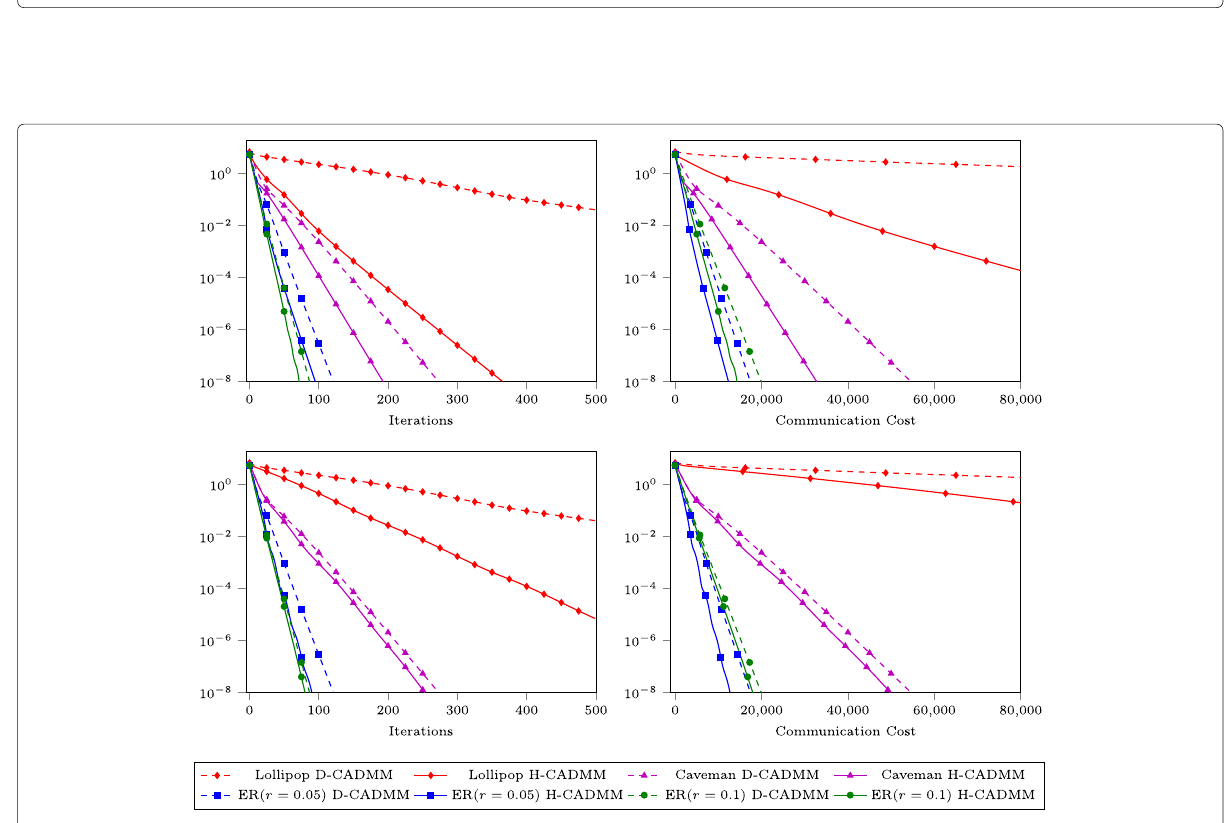
Fig. 5 Performance comparison of D-CADMM and H-CADMM in terms of iteration number as well as communication cost. H-CADMM is configured with one dedicated FC connecting 50% of the nodes (top row figures) and 20% of the nodes, respectively (bottom row